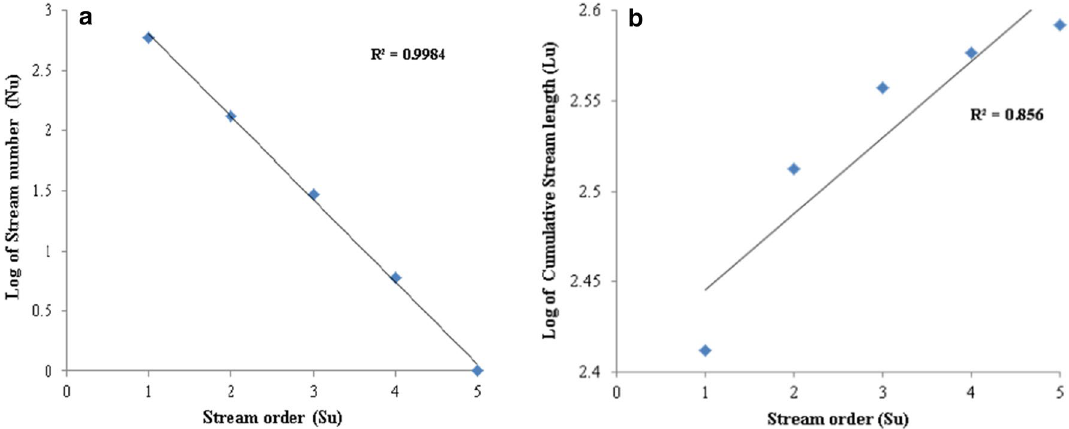
Fig. 3 Graph showing a Relationship between the stream order and stream number, and b relationship between the stream order and stream